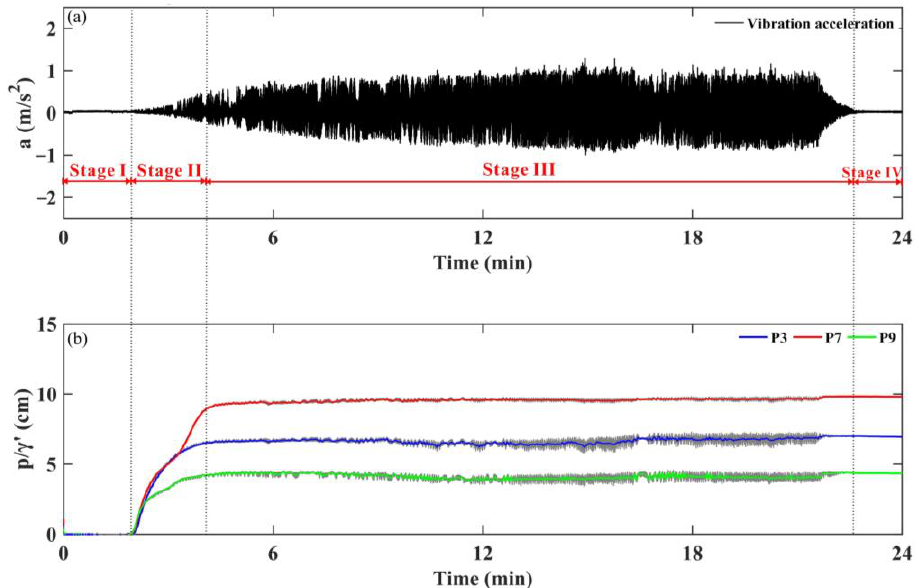
Figure 4. Time series of vibration acceleration ( a ) and excess pore pressure ( b ) in Test 13, where a is the measured vibration acceleration, p is the excess pore pressure, and γ is the specific weight of water.